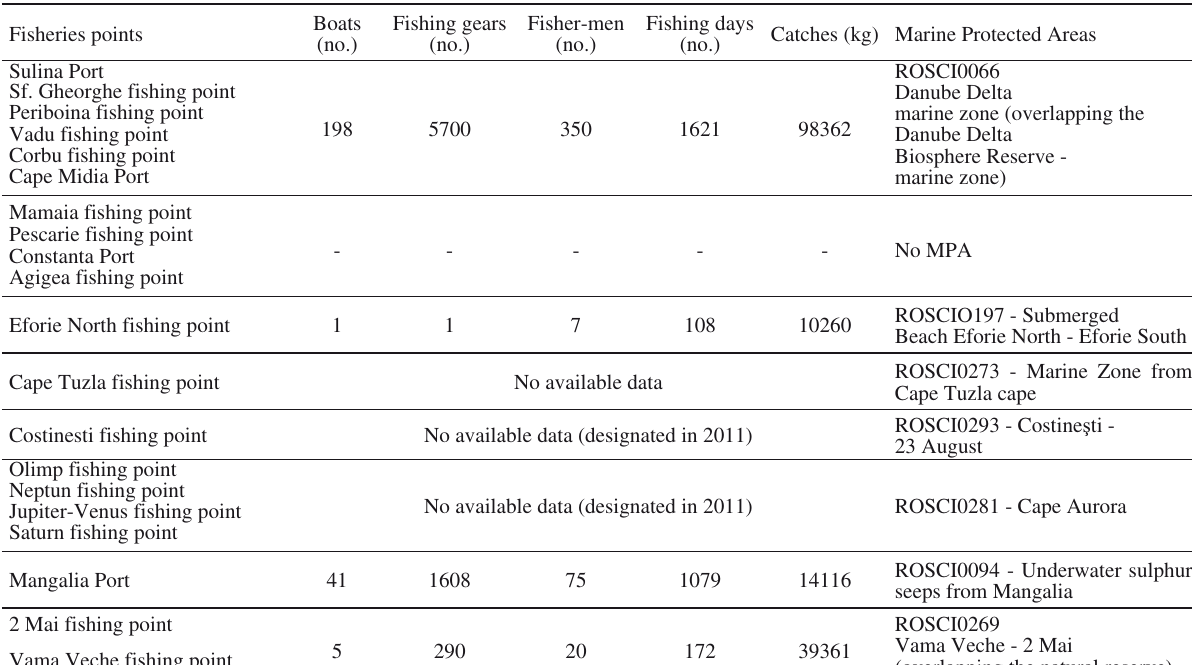
Table 3. – Correlation between fisheries and MPAs on the Romanian littoral in 2010.